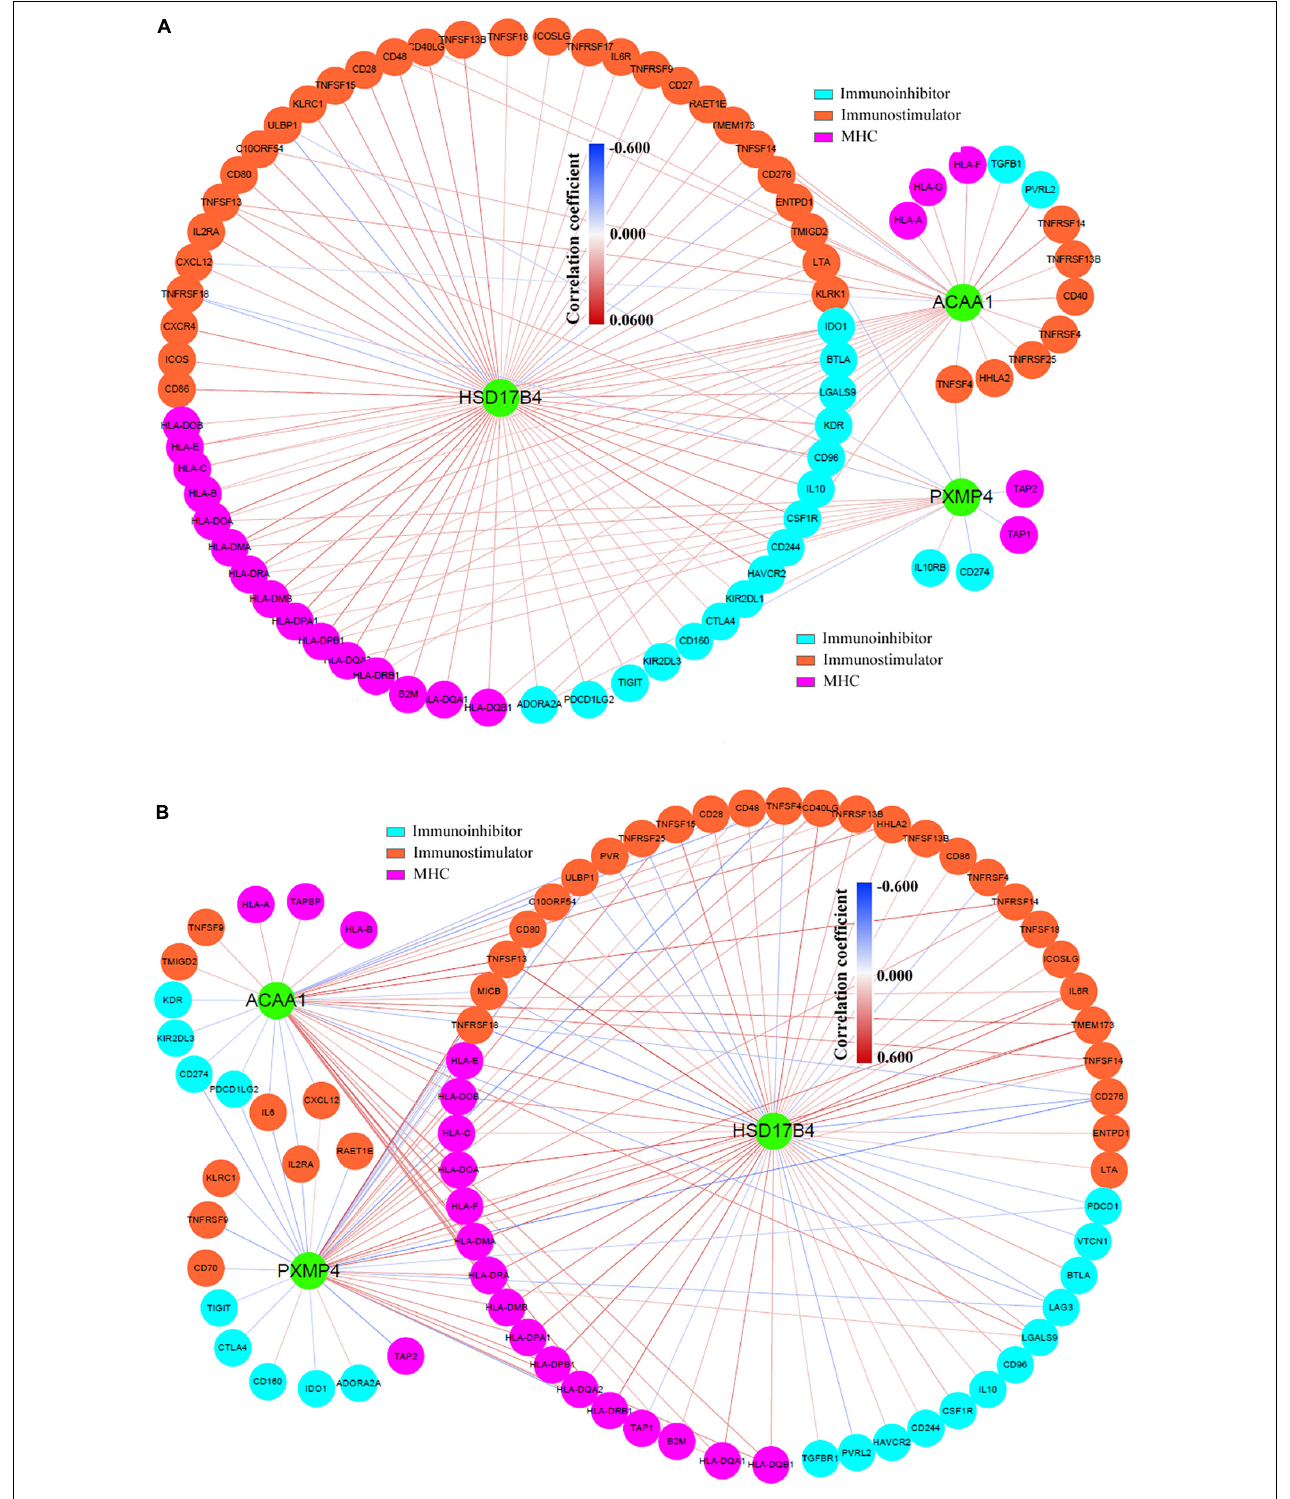
FIGURE 9 | Significant c orrelations between HSD17B4, ACAA1, and PXMP4 expressions and immunomodulator gene expressions. (A) There were 114 significant positive or negative correlations between HSD17B4, ACAA1, and PXMP4 expressions and immunomodulator gene expressions in LUSC. (B) There were 145 significant positive or negative correlations between HSD17B4, ACAA1, and PXMP4 expressions and immunomodulator gene expressions in LUAD. The nodes and the edges represented the genes and the correlations, respectively. Purity-corrected Spearman correlation was used and p < 0.01 was considered significant.